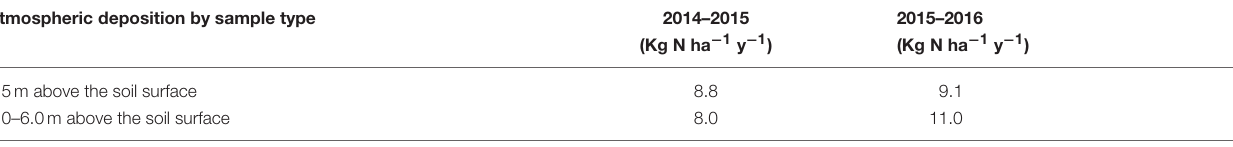
TABLE 1 | Atmospheric N deposition at the Brooklyn Grange Navy Yard farm, NYC, between 11/12/2014 and 11/12/2015, and between 11/12/2015 and 11/12/2016, compared with other studies. Atmospheric deposition by sample type